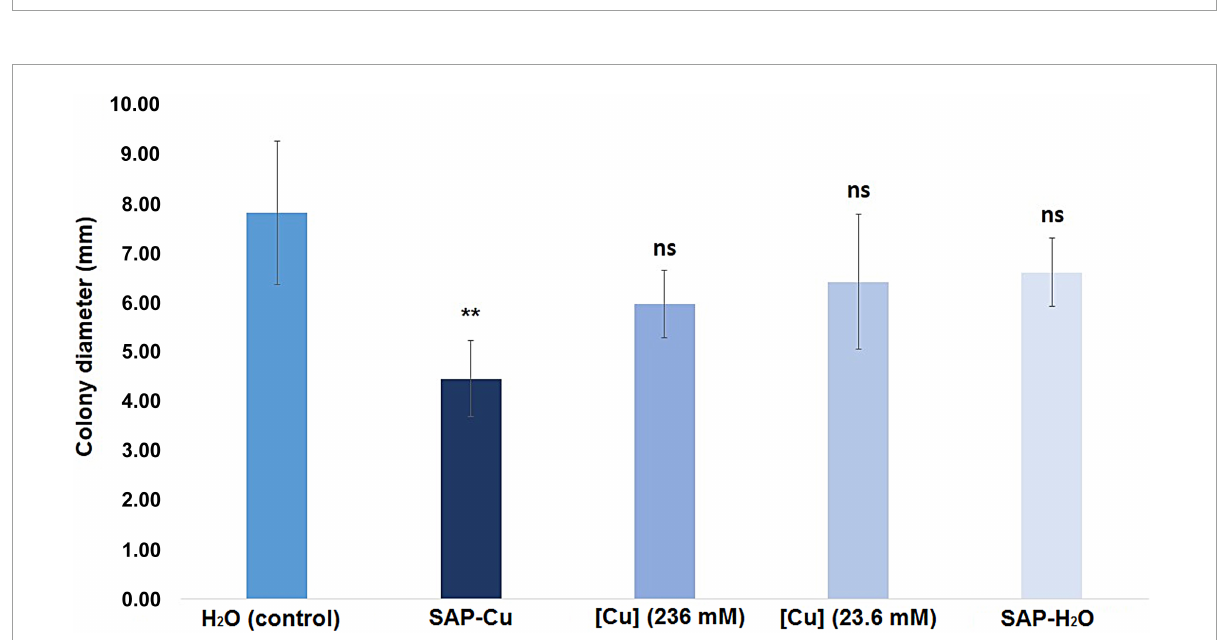
FIGURE8 Effect of Cu-containing SAP (SAP-Cu), CuSO 4 · 5H 2 O-aqueous solution, both at the concentration of 236 mM of Cu 2 + , CuSO 4 · 5H 2 O-aqueous solution at the concentration of 23.6 mM of Cu 2 + and H 2 O-containing SAP (SAP-H 2 O) on the mycelial growth of Plenodomus tracheiphilus in naturally infected twigs (cfr. Figure 2 ). Error bars represent the standard deviation of the means ( n = 36). Columns with asterisks are statistically different according with Dunnett’s test (** P < 0.01, ns = not significant), compared to the